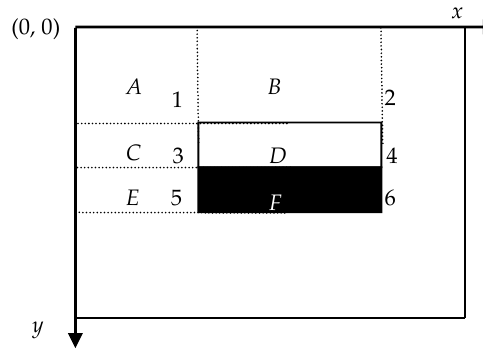
Figure 5. Example calculation of an arbitrarily sized upright Haar-like feature.